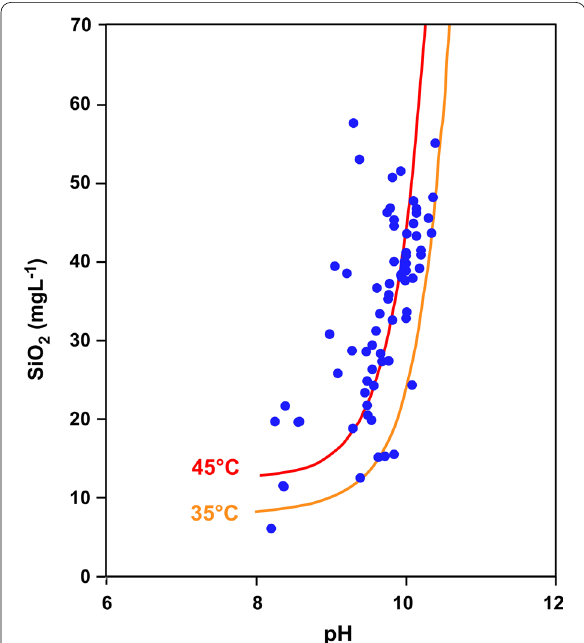
Fig. 9 Dissolved aqueous silica in mg L − 1 vs. pH. Computed saturation with respect to quartz at 35 °C and 45 °C from